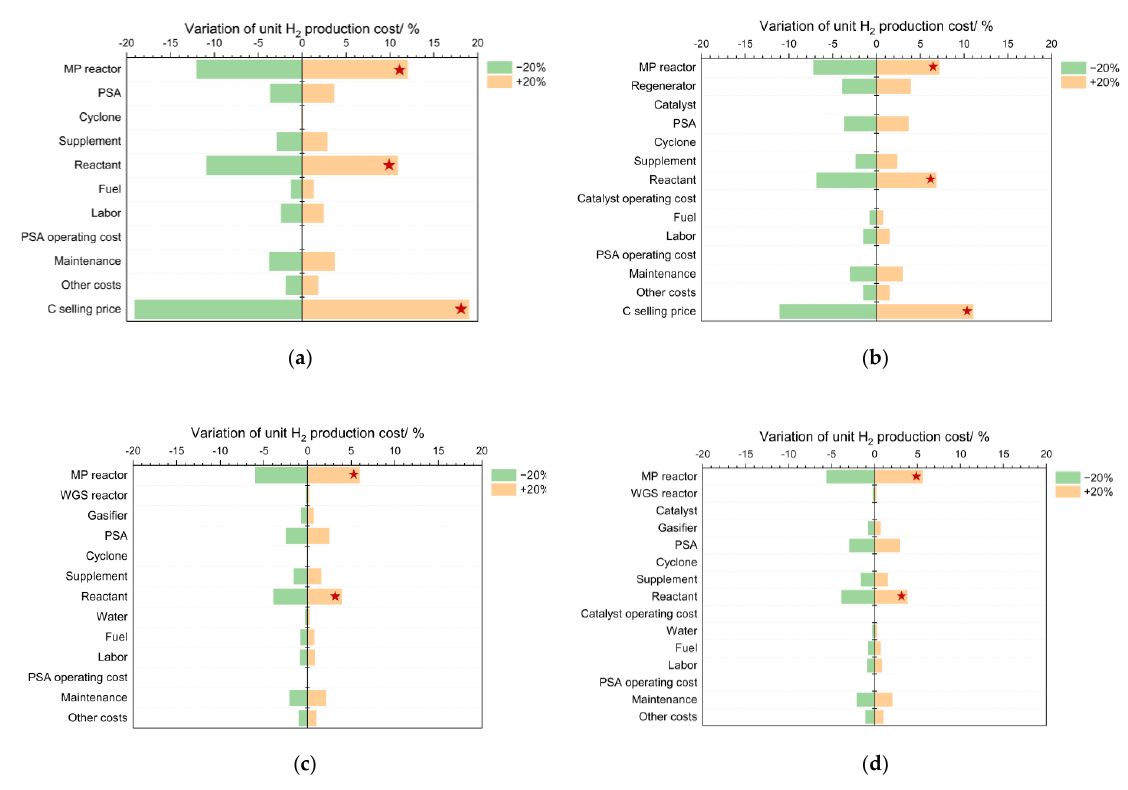
Figure 8. Results of sensitivity analysis for methane pyrolysis (MP) systems of ( a ) thermal methane pyrolysis (TMP-S1), ( b ) catalytic methane pyrolysis (CMP-S2), and the systems with additional gasification and WGS reaction of ( c ) TMPG-S3 and ( d ) CMPG-S4.